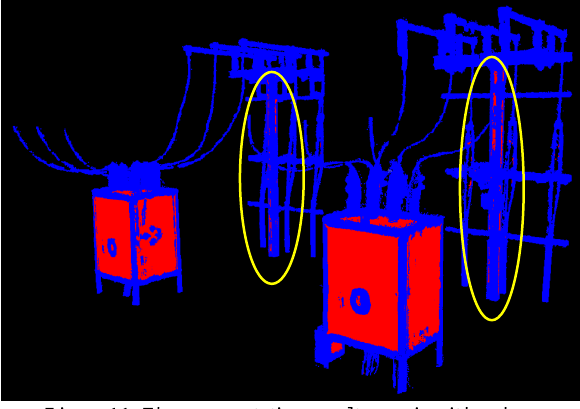
Figure 11. The segmentation results on circuit breakers achieved by PCA using Faro subset